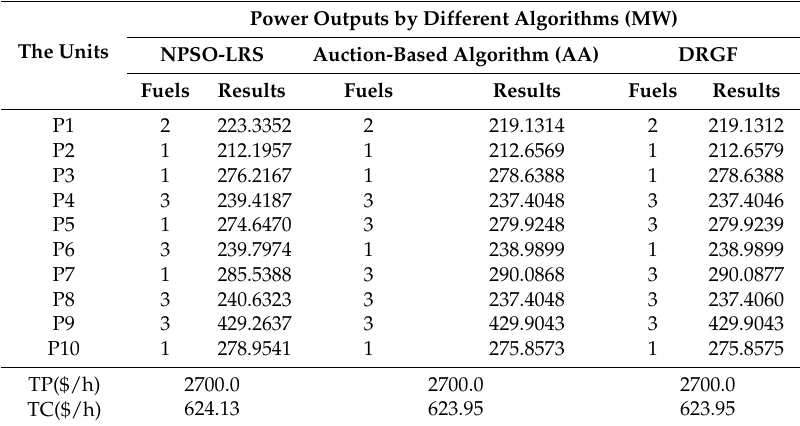
Table 2. Optimization results of 10 units test system.